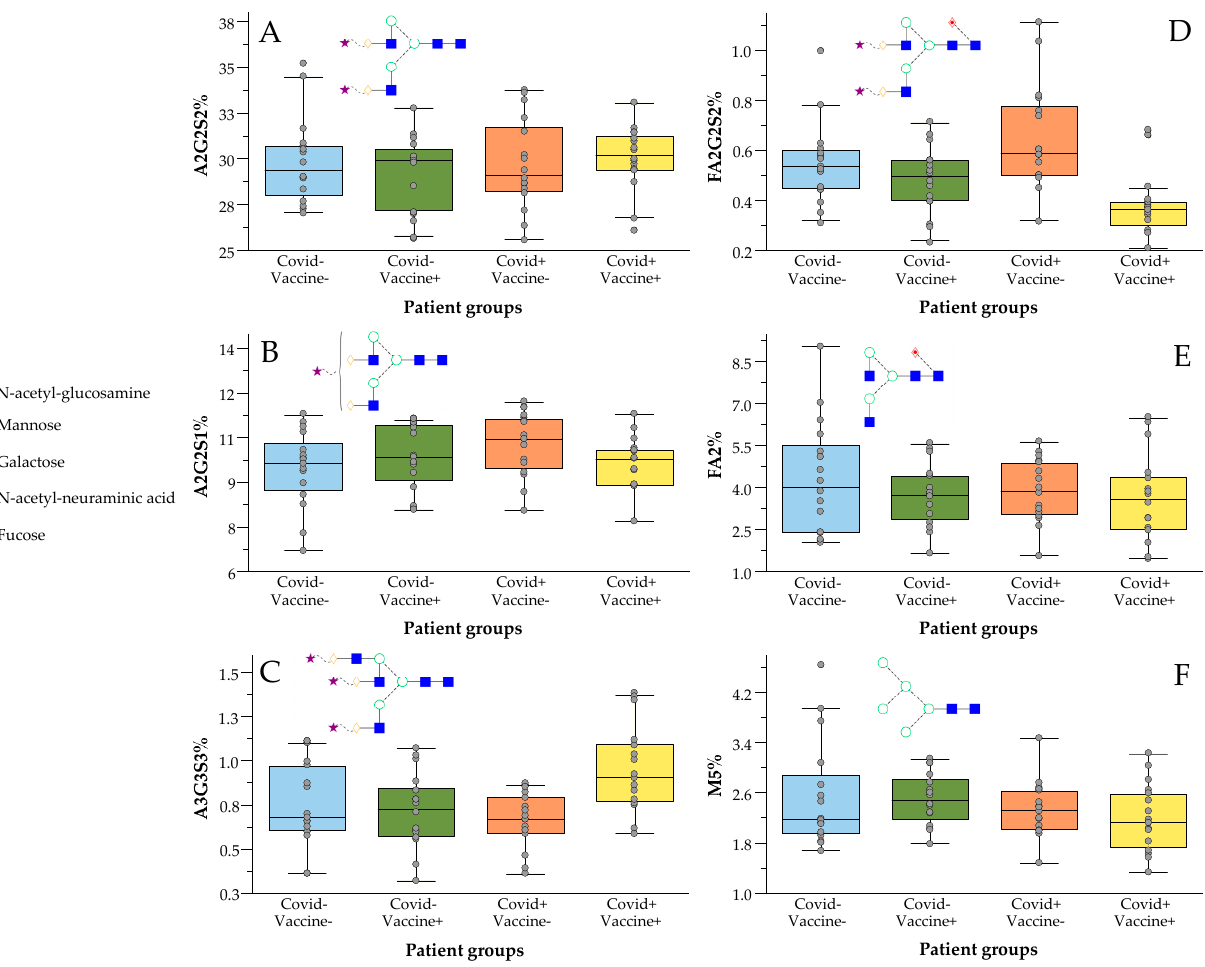
Figure 2. Increased sialylation and decreased fucosylation levels in response to vaccination against SARS-CoV-2 virus (( A ) A2G2S2; ( B ) A2G2S1; ( C ) A3G3S3; ( D ) FA2G2S2; ( E ) FA2; ( F )M5).